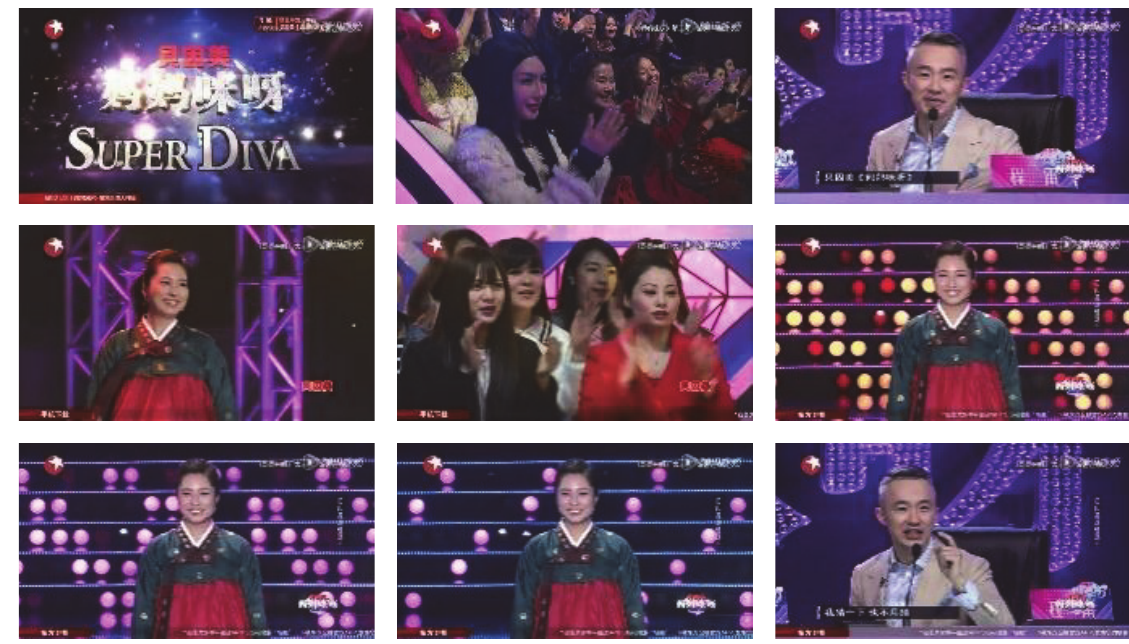
Figure 6: Examples of alternative key